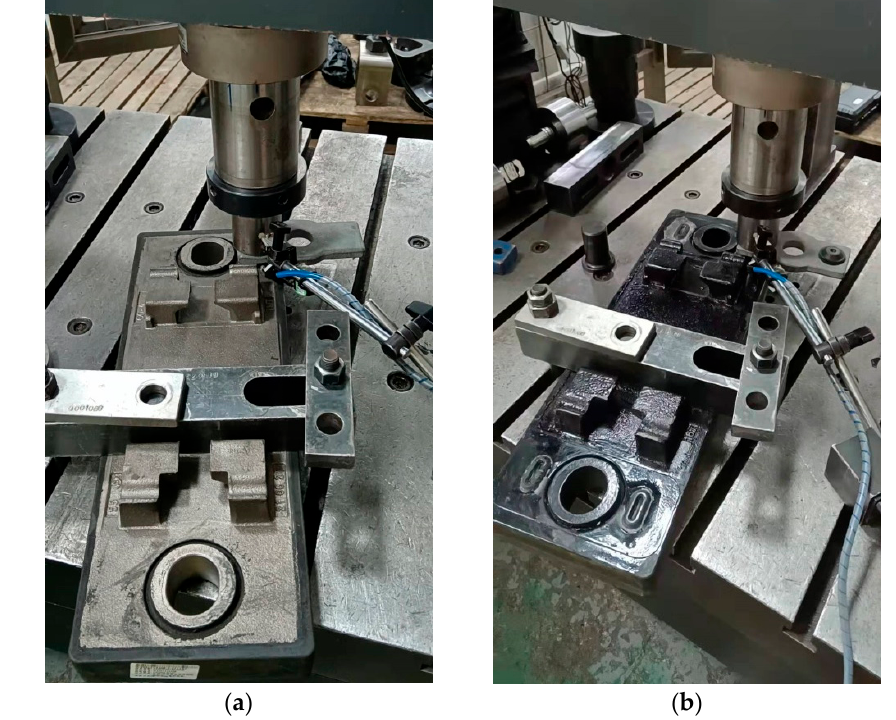
Figure 6. Experiment setup for Experimental conditions ( a ) 3 and ( b ) 4.